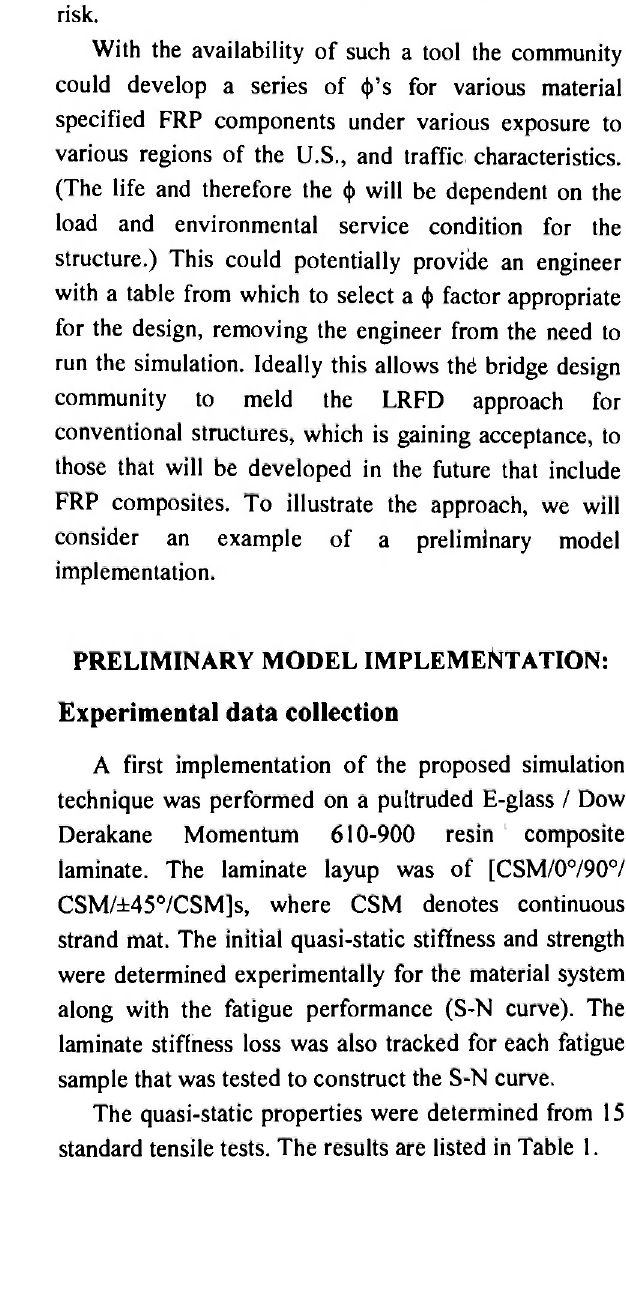
Fig. 4: Laminate S-N